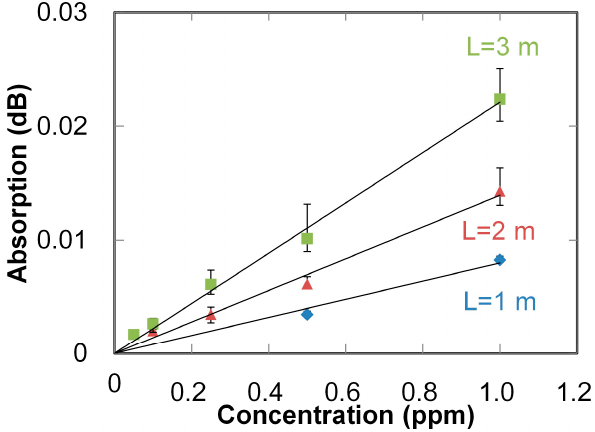
Figure 6. Correlations between absorptions of NO sample gases measured at 215 nm and NO gas concentration measured with different fiber lengths.